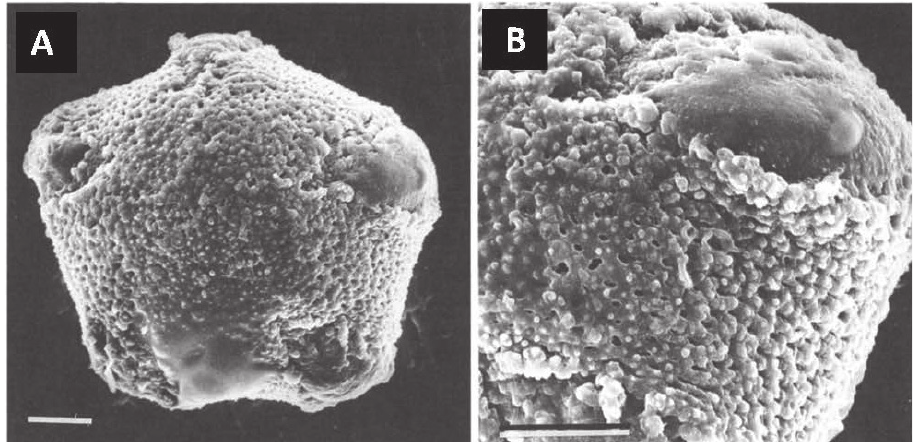
Figure 2. Pollen morphology of Monadelpha guayanensis A SEM of pollen grain showing polar view with five colpi B closeup of mesocolpium and two colpi. Source: Stergios & Aymard 9182 (MO). Figure reproduced from Gillespie (1994b) with permission from the Missouri Botanical Garden